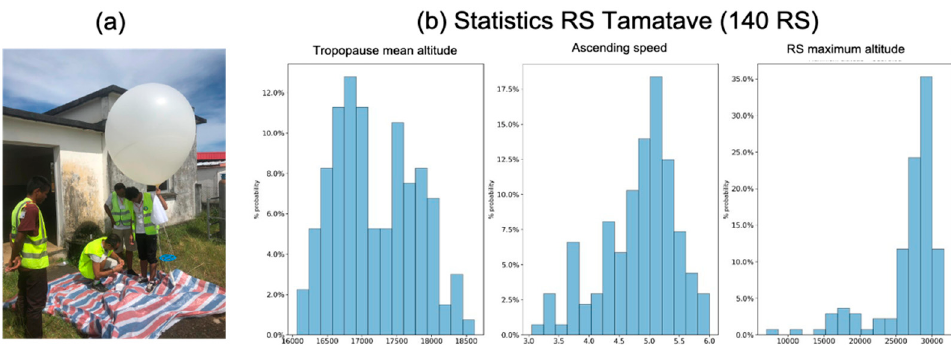
Figure 3. The Toamasina (Madagascar) radiosounding campaign. ( a ) Training of students from Antananarivo University at Toamasina airport. ( b ) Statistical analysis of the 140 RS measurements performed in Toamasina: mean altitude of the tropopause, ascending speed, and maximum RS altitude. Picture: Olivier Bousquet